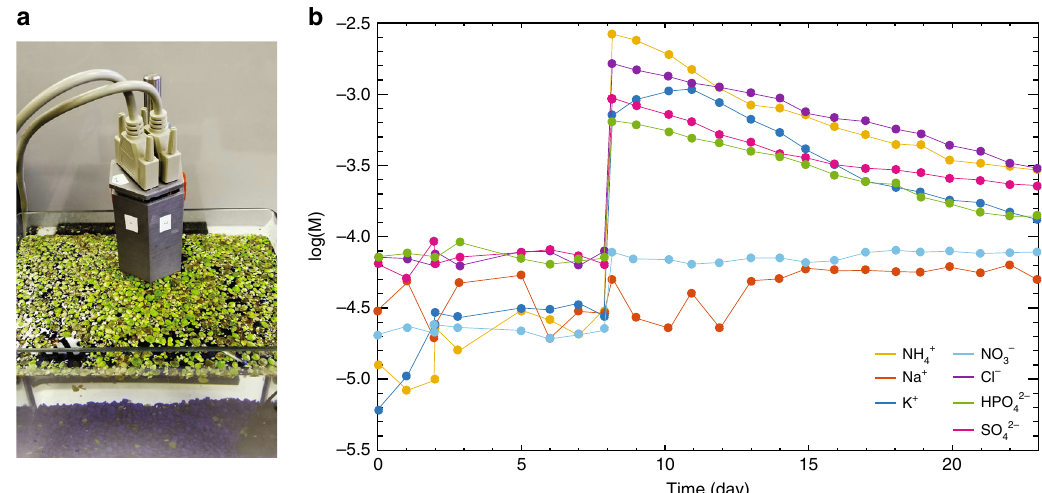
Fig. 7 Measuring ion concentrations in an aquarium. a An optical image of the ISFET array in an aquarium containing duckweed. b The measured ion concentrations in the aquarium over time. The concentrations were calculated from the measured currents using the series of Nikolskii – Eisenman equations. After the eighth day, salts were added to the aquarium as nutrients for the